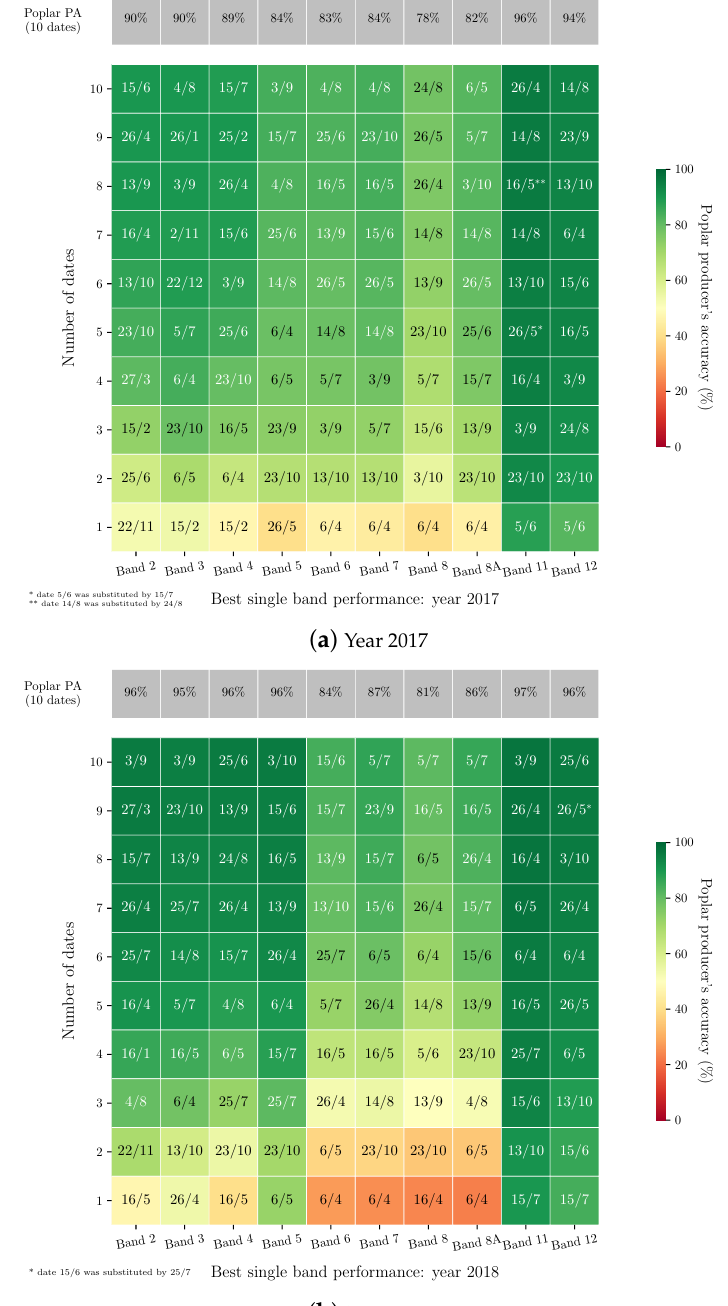
Figure 7. Average poplar PA as a function of the number of features selected with SFFS in the single-band configuration: in ( a ), single-band SFFS results in 2017; in ( b ), single-band SFFS results in 2018. The y-axis represents the number of features, from 1 to a maximum of 10, for each individual spectral band on the x-axis. The colours on the red-yellow-green scheme palette reflect the poplar’s PA values. The selected dates are given inside the